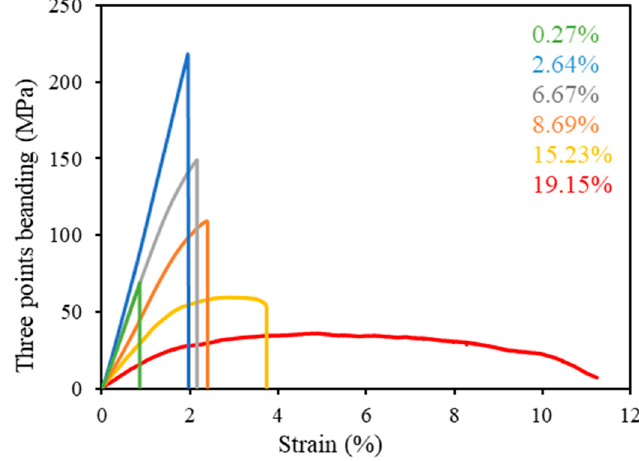
Figure 5. The three-point bending curve of RS hot-rolled resins (50% reduction ratio) with boiling treatment in the rolling direction.